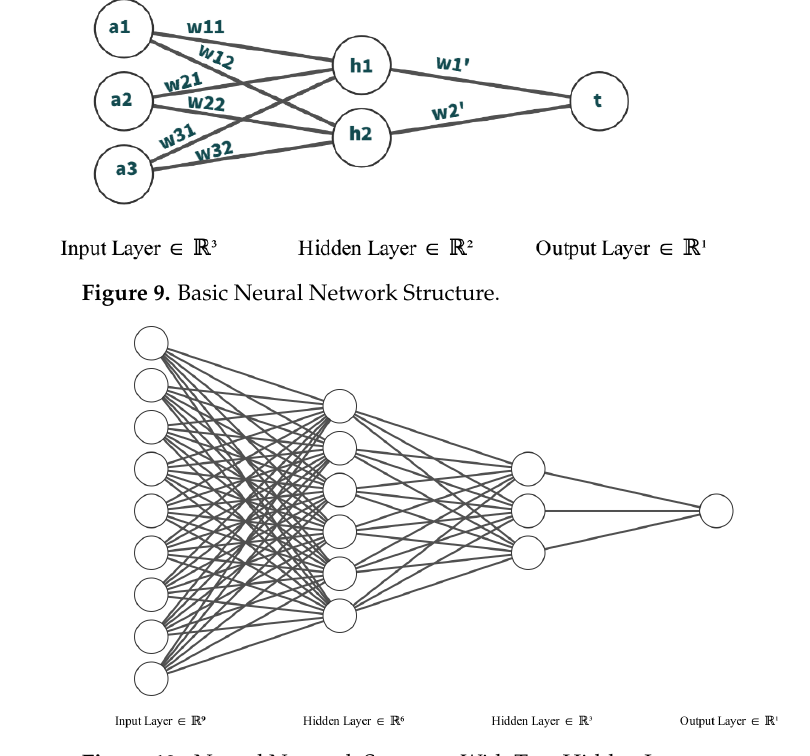
Figure 10. Neural Network Structure With Two Hidden Layer.